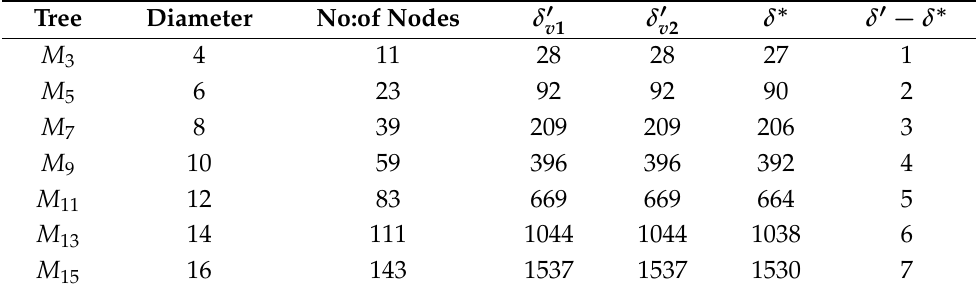
Table 2. Comparison of δ (cid:48) and δ ∗ on millipede trees with various diameters. Tree